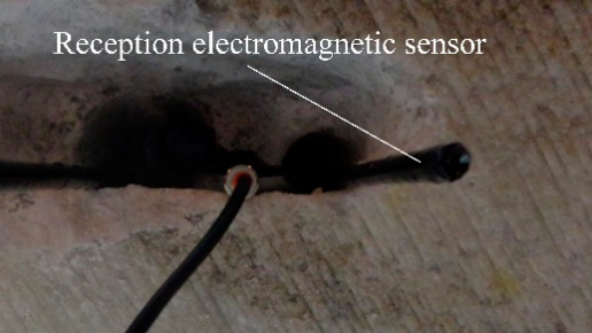
Figure 9. Reception electromagnetic sensor introduced in saline environment for vertical plane.